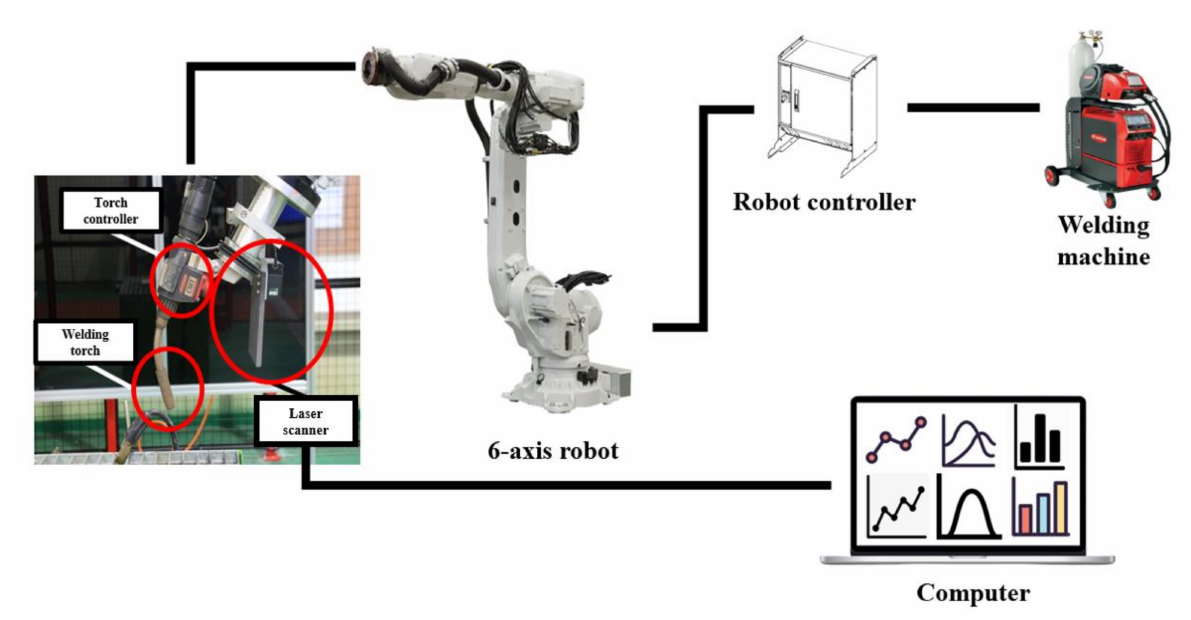
Figure 5. Experimental setup of the WAAM